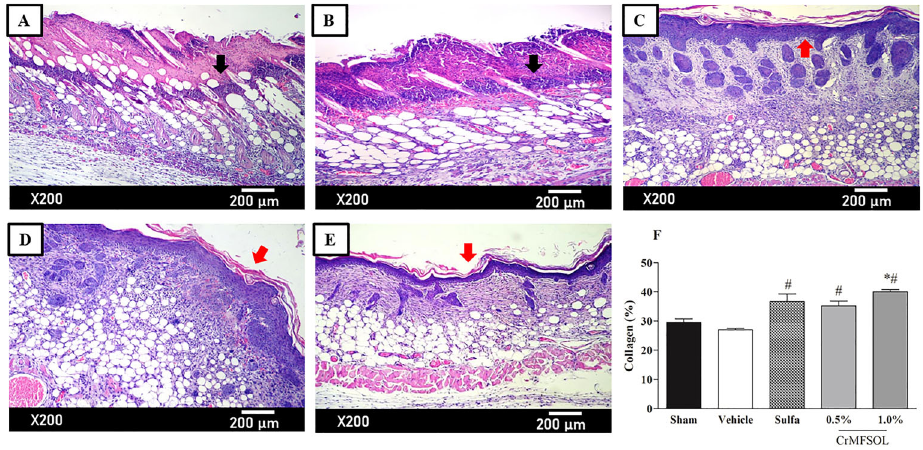
Figure 5. Cream of methanol fraction of Sideroxylon obtusifolium (CrMFSOL) promoted improved tissue remodeling, reepithelialization, and stimulated collagen production on super fi cial burns 7 days after treatment. Photomicrographs of histological slides (hematoxylin- eosin staining) of burn lesions on the 7th day after injury for the groups Sham ( A ), Vehicle ( B ), silver sulfadiazine ( C ), 0.5% CrMFSOL ( D ), and 1.0% CrMFSOL ( E ) (n=6 animals/group). Black arrows indicate the presence of acute in fl ammatory in fi ltrate in groups A and B , while red arrows indicate the presence of atrophic epithelium, presence of a corneal layer, and absence of ulcer in groups C , D , and E . The lesions were stained with picrosirius red and photographed in six fi elds (200 (cid:1) , scale bar 200 m m). The percentage of total collagen present on the 7th day was determined by the ImageJ s software ( F ). The data are reported as mean ± SE of the six areas of each wound per group. *P o 0.05 compared to the Sham group; # P o 0.05 compared to the Vehicle group (n=6 animals/group per day) (one-way ANOVA followed by the Tukey